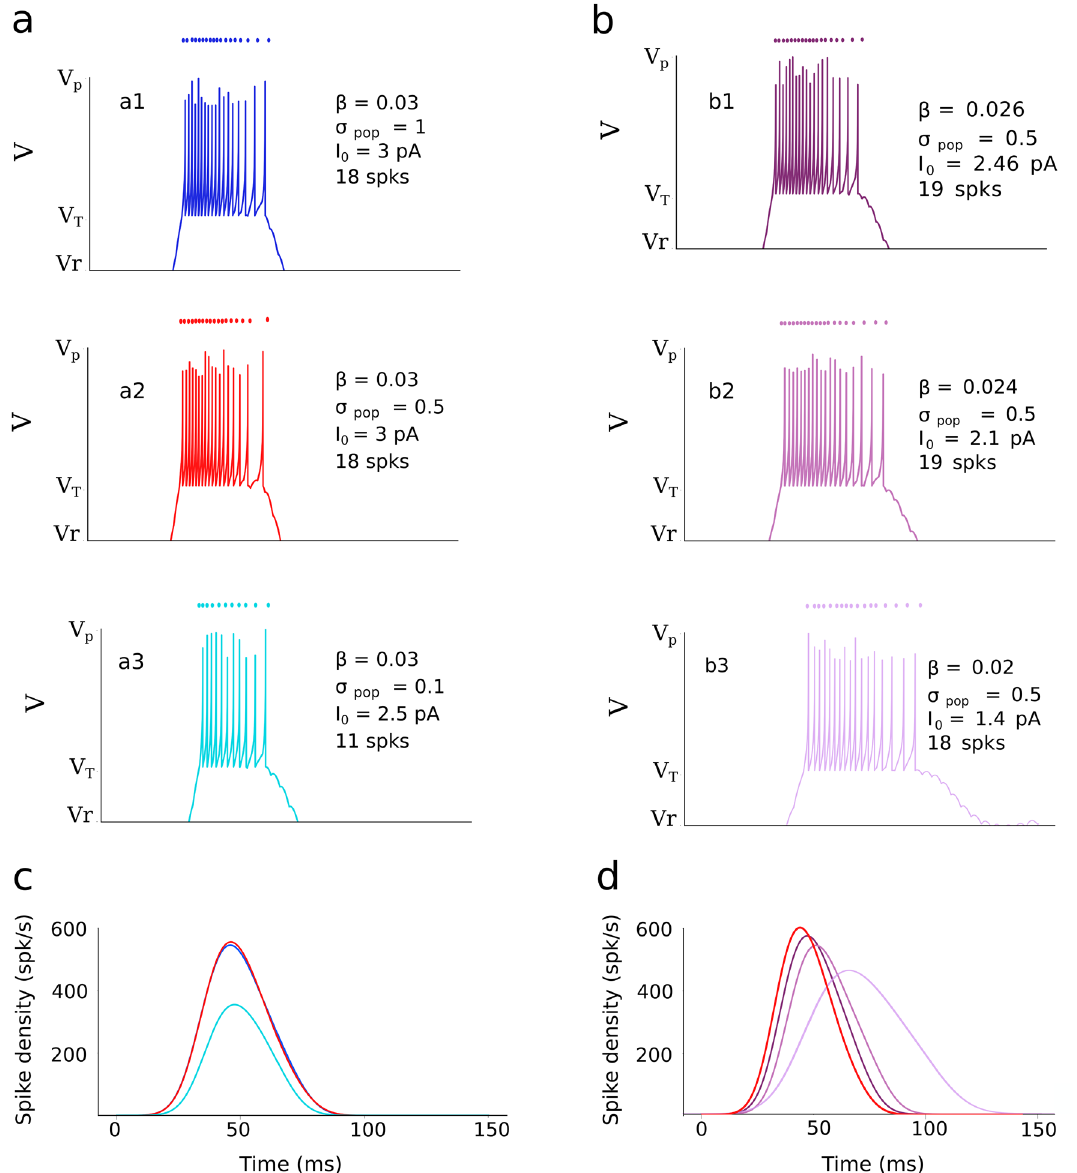
Figure 5. Effect of varying external current input parameters, such as the recruited input population size (σ pop ), stimulus duration (β), and input stimulus amplitude (I 0 ) on the bursting characteristics of an AdEx neuron at u n = 2.5 mm (neuron nr. 100) in the SC output layer [τ q = 30, W FS = 3]. ( a , b ) Show the membrane potential, V(t), and a dot-display of the individual spikes (top), for three input current population sizes around T = 15 deg: (a1) σ pop = 1.0 mm, (a2), σ pop = 0.5 mm (the default stimulation input), (a3) σ pop = 0.1 mm, and for three stimulus duration/intensity values: (b1) β = 0.026/I 0 = 2.46, (b2) β = 0.024/I 0 = 2.1, (b3) β = 0.020/I 0 = 1.4. ( c ) Corresponding spike density functions for varying the external stimulation population size, and ( d ) for varying the external stimulus duration/intensity parameters. Line colors correspond to the traces in ( a , b activity patterns for the entire motor map for each of the different input populations. Note that the burst dura- tions were the same for all stimulus conditions. The few late spikes that are visible at the rostral end of the population (at the bottom of the panels), especially for the strongest inputs, are due to the rostral-caudal gradient in our revised lateral interaction scheme (Fig. 4; Eq. (4)). This causes slightly more net excitatory input weight to the rostral SC neurons than to the caudal SC neurons. These few extra spikes, however, add very little to the total saccade amplitude and kinematics, which are determined by all spikes within the total population (Eq. S1). In our earlier model 40 this late rostral tail was absent as there the lateral interactions were taken identical across the entire motor map (see Fig. 9 in 40 ). Figure 7a,b shows the SC responses across the motor map while varying the duration parameter β of the input stimulus between 0.019 s −1 (long) and 0.03 s −1 (the default), for a fixed population size ( σ pop = 0.5 mm). The input current intensity, I 0 , co-varied with β between 1.2 and 3.0 pA in such a way that the number of spikes emitted